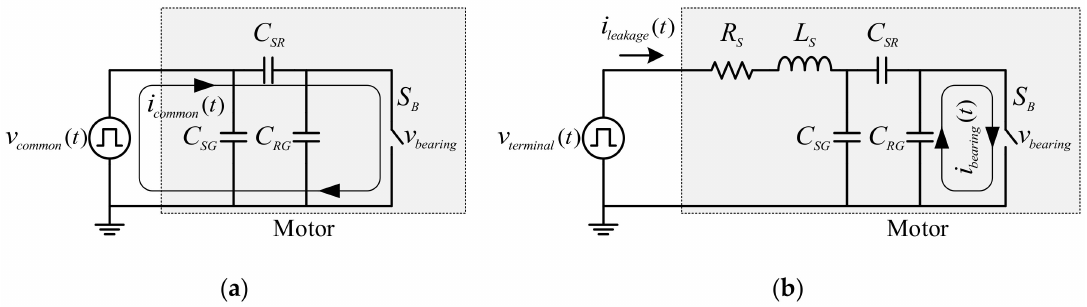
Figure 3. Simplified equivalent circuit of ( a ) common mode and ( b ) leakage current.